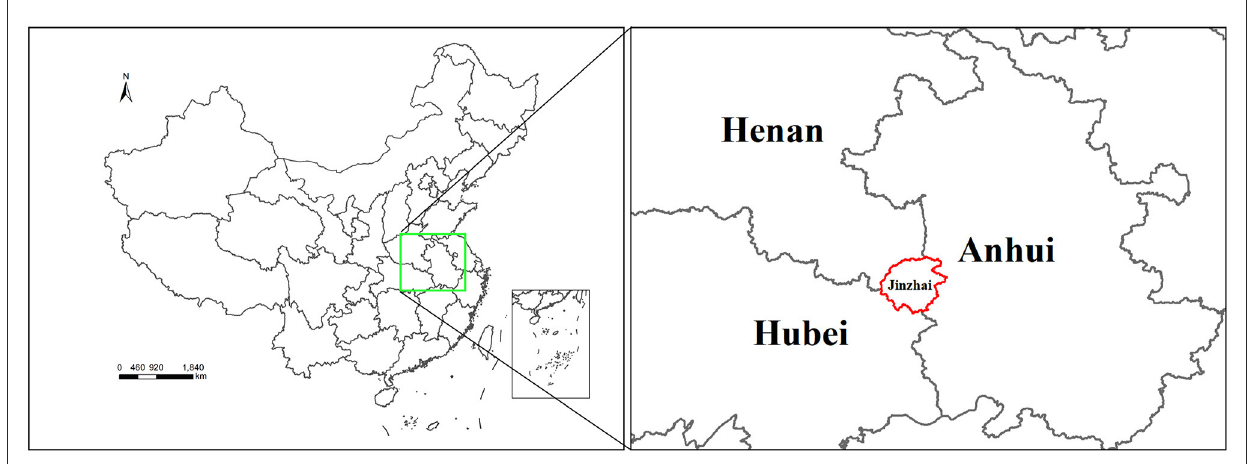
FIGURE1 Map showing the location of tick sample collection sites in Jinzhai County, Lu’an City, Anhui Province, China. The region highlighted with a red border indicates the sampling region in this